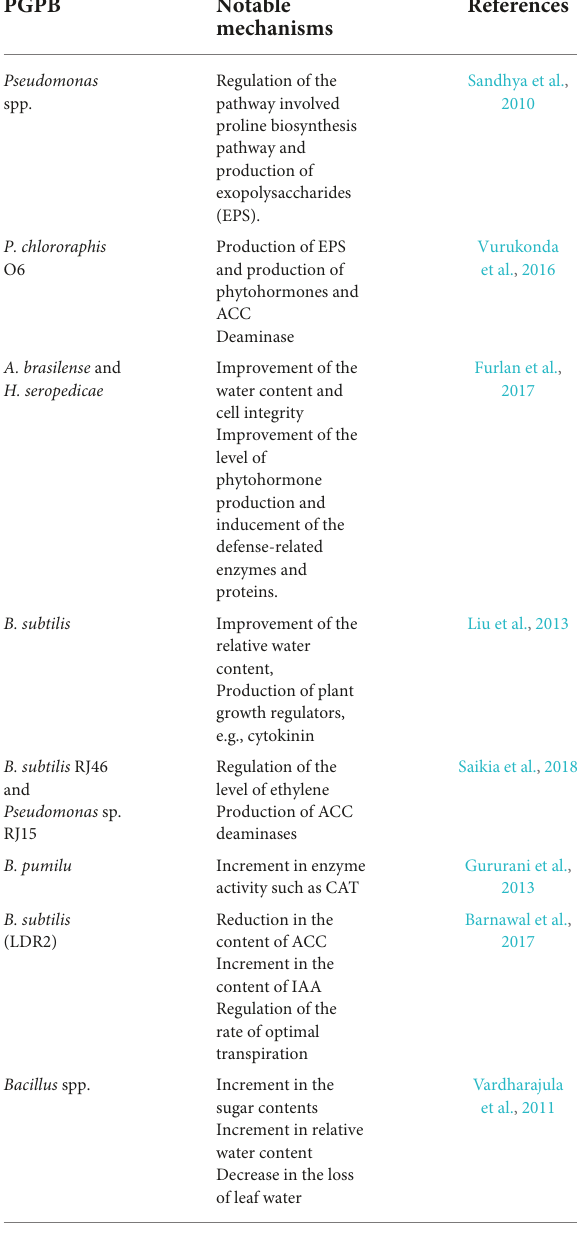
TABLE 2 Mechanisms used by some selected PGPB for the enhancement of plant drought tolerance. PGPB Notable